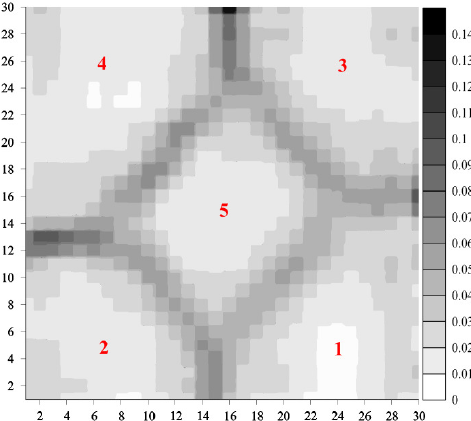
Figure 7. Gray-level U-matrix map for the visualization of the synthetic data set of Figure 5a (U-matrix is calculated for the neuron map of Figure